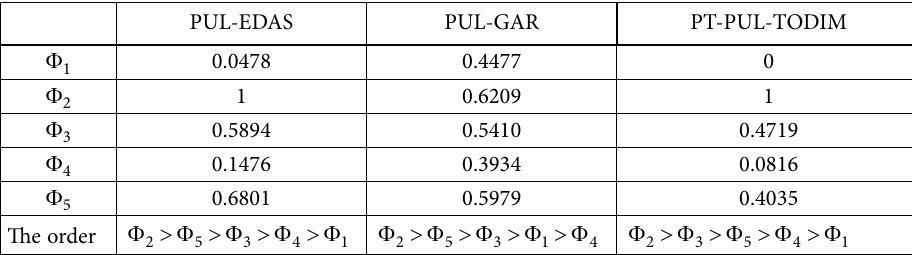
Table 14. Comparison of different